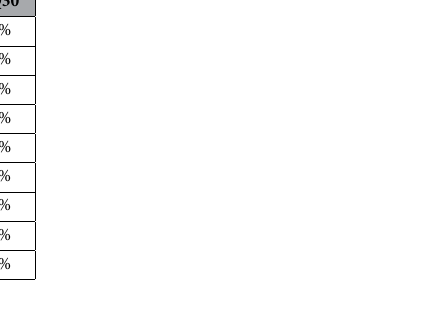
Table 3. Statistical table of sequencing data.